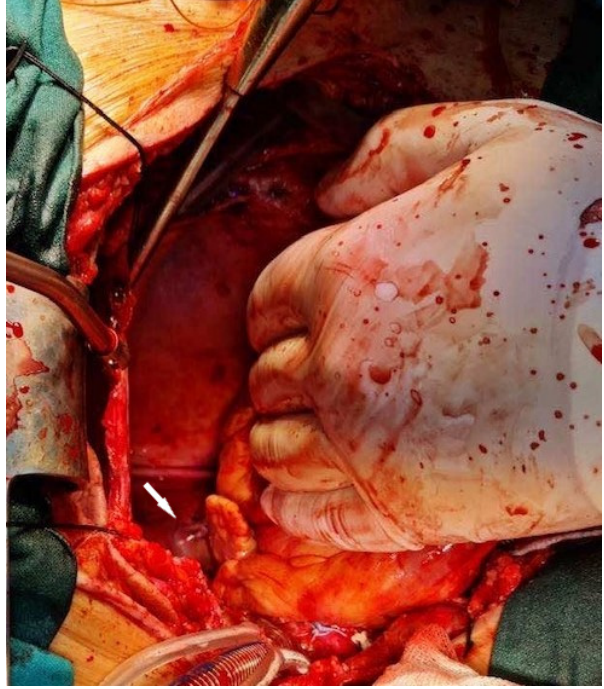
Fig. 3 - Surgical view of the sutured left inferior pulmonary vein. White arrow = left inferior pulmonary